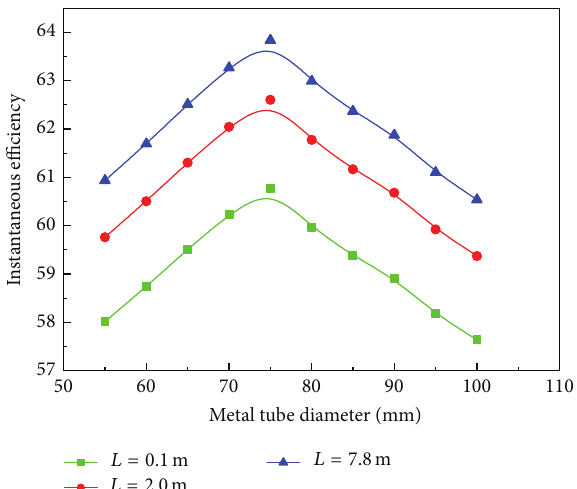
Figure 8: The influence of metal tube diameter on the instantaneous